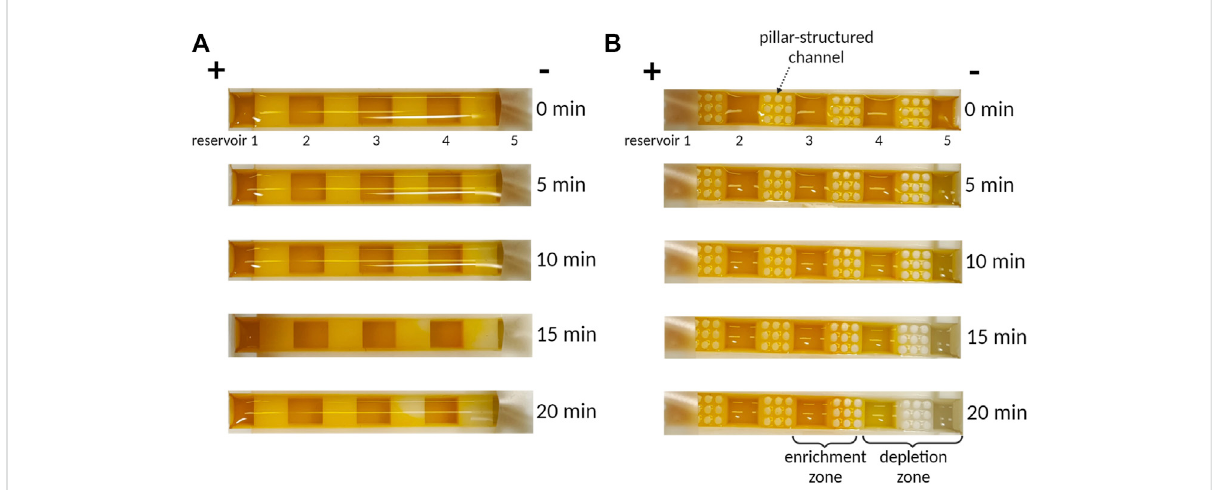
FIGURE 4 The photographs ofpreconcentration of Orange-G dyeaccordingto time. (A) Without pillarstructure, depletion zonepropagation isweak due to unstable vortex fl ux. (B) With a pillar structure, depletion zone propagation is strong to go more than twice that of without